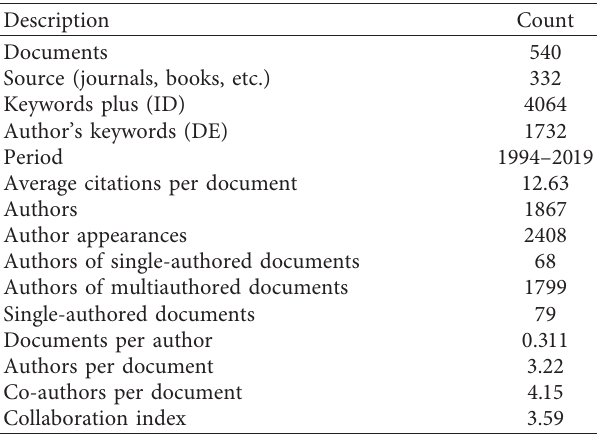
Table 1: Summary of data retrieved from Scopus